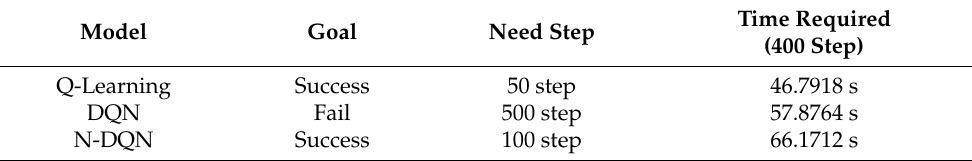
Figure 10. The result of 5 × 5 maze game through N-DQN. Table 4. Summary of 5 × 5 learning results. Table 4. Summary of 5 × 5 learning results.